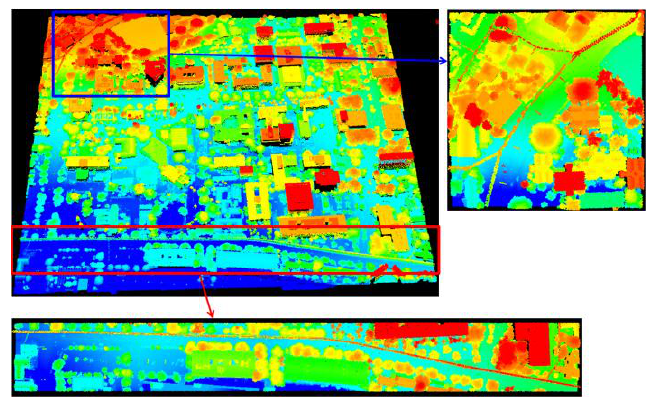
Figure 2. Visualisation of the experiments for UL Dataset (top) and LP Dataset (bottom) with the true power